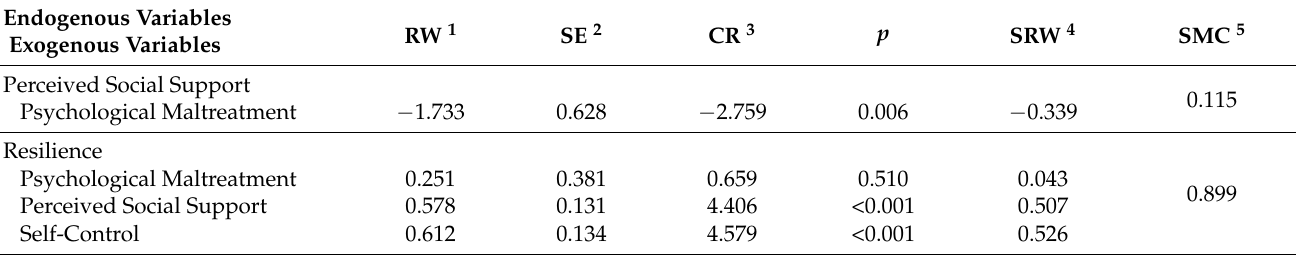
Table 6. Standardized Estimations of the Hypothetical